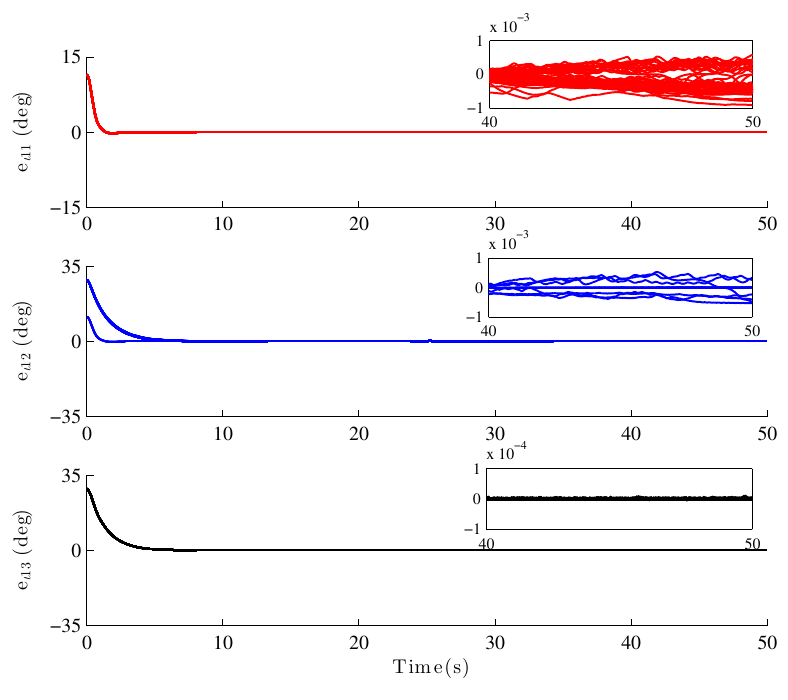
Figure 7. Time response of the tracking errors in the MC simulation.